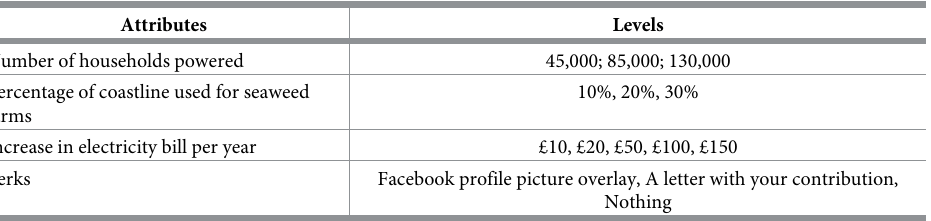
Table 1. Attributes and their